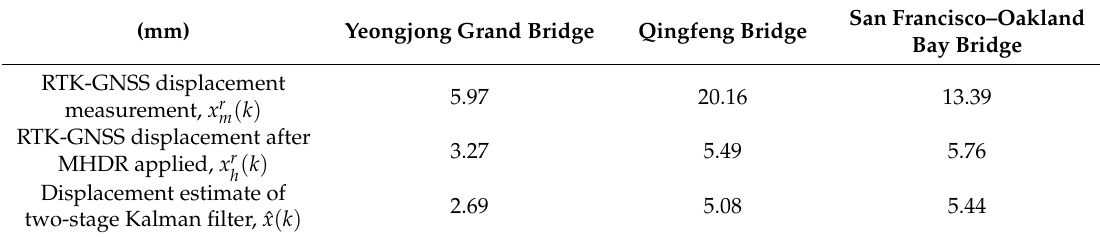
Table 1. RMSEs of estimates from the measurements of each field test.